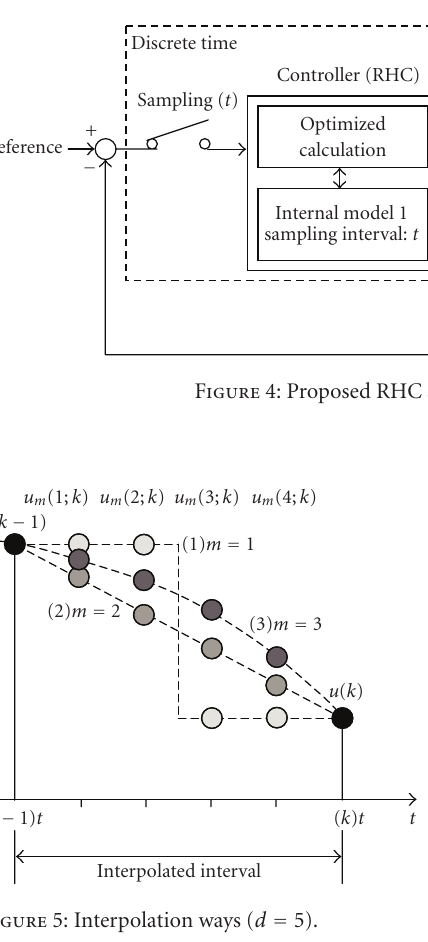
Figure 5: Interpolation ways ( d = 5).